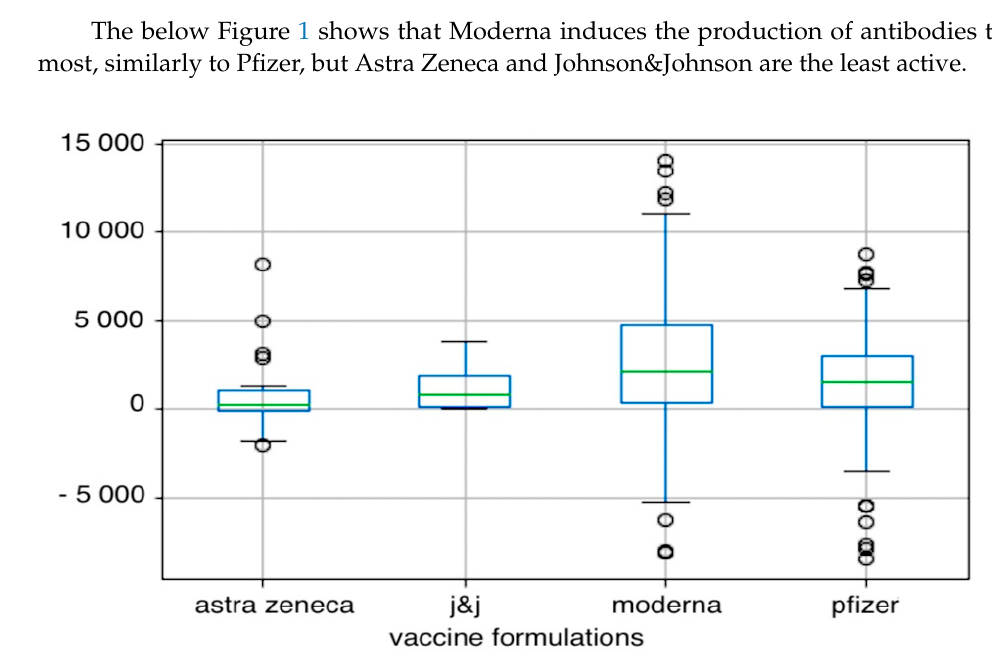
Table 6. Antibodies levels after particular SARS-CoV-2 vaccines.